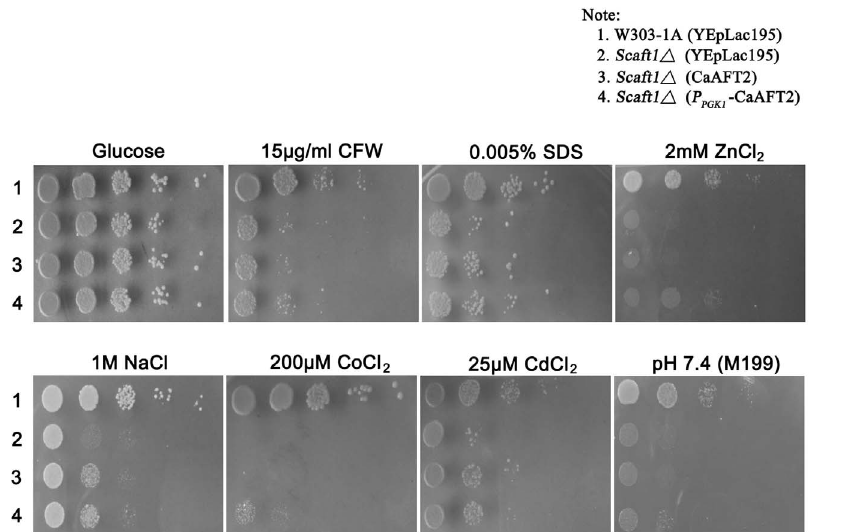
Figure 4. Aft-type regulator in C.albicans fails to complement the non-iron related phenotypes of S.cerevisiaeaft1 D mutant. Overnight cultures of S. cerevisiae W303 derivatives (NKF24, NKF52, NKF53 and NKF55) were grown to mid-exponential phase, and resuspended in